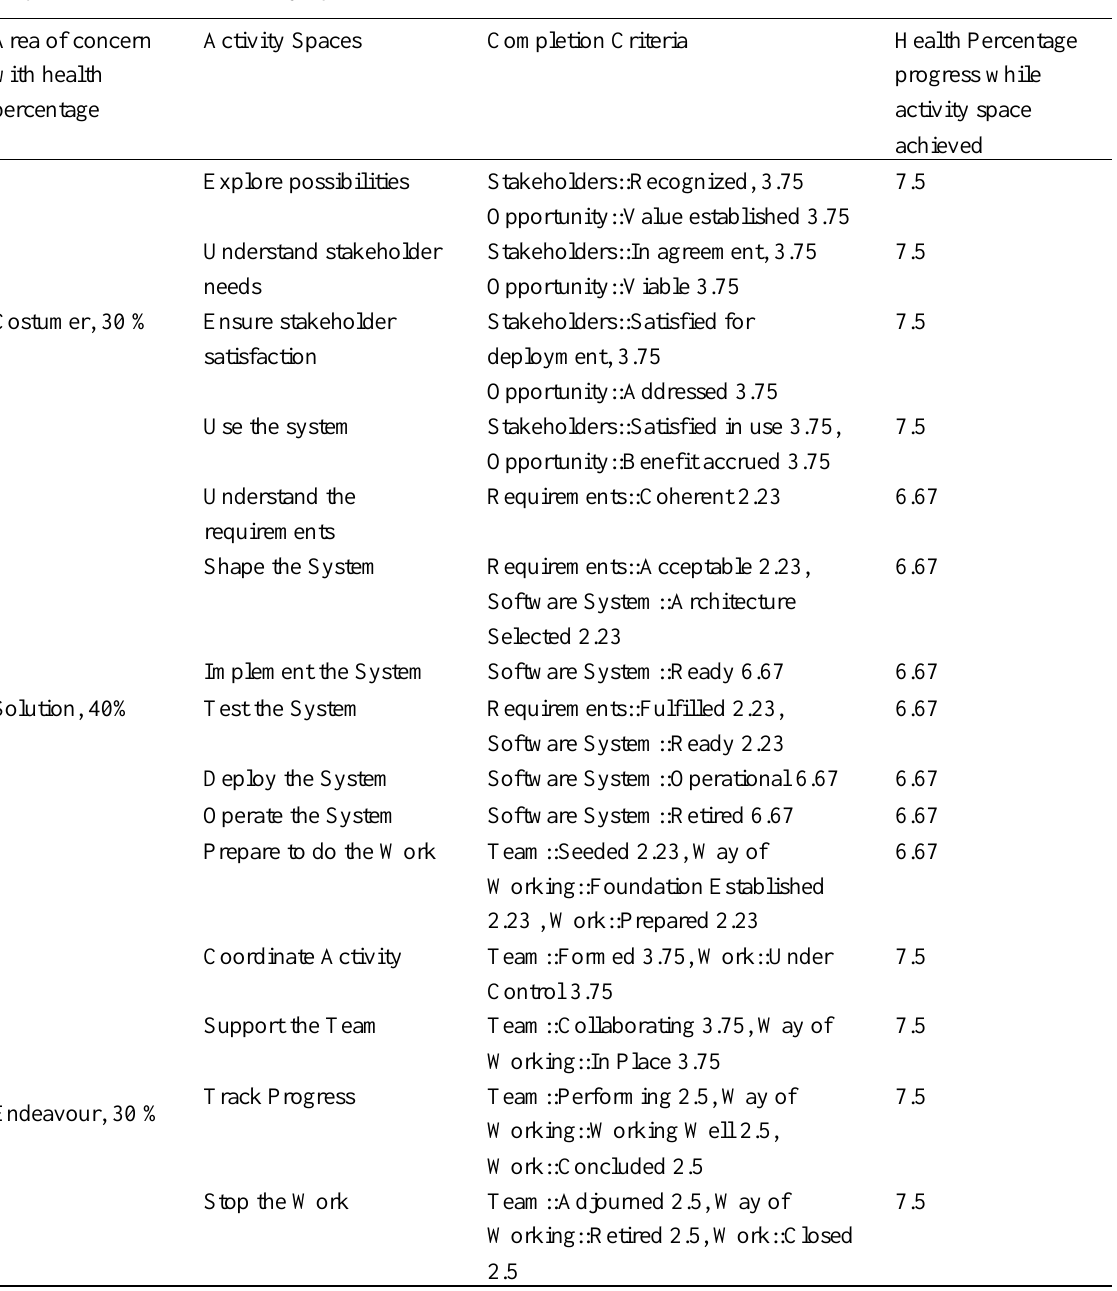
Table 3 Completion Criteria for Activity Spaces Area of